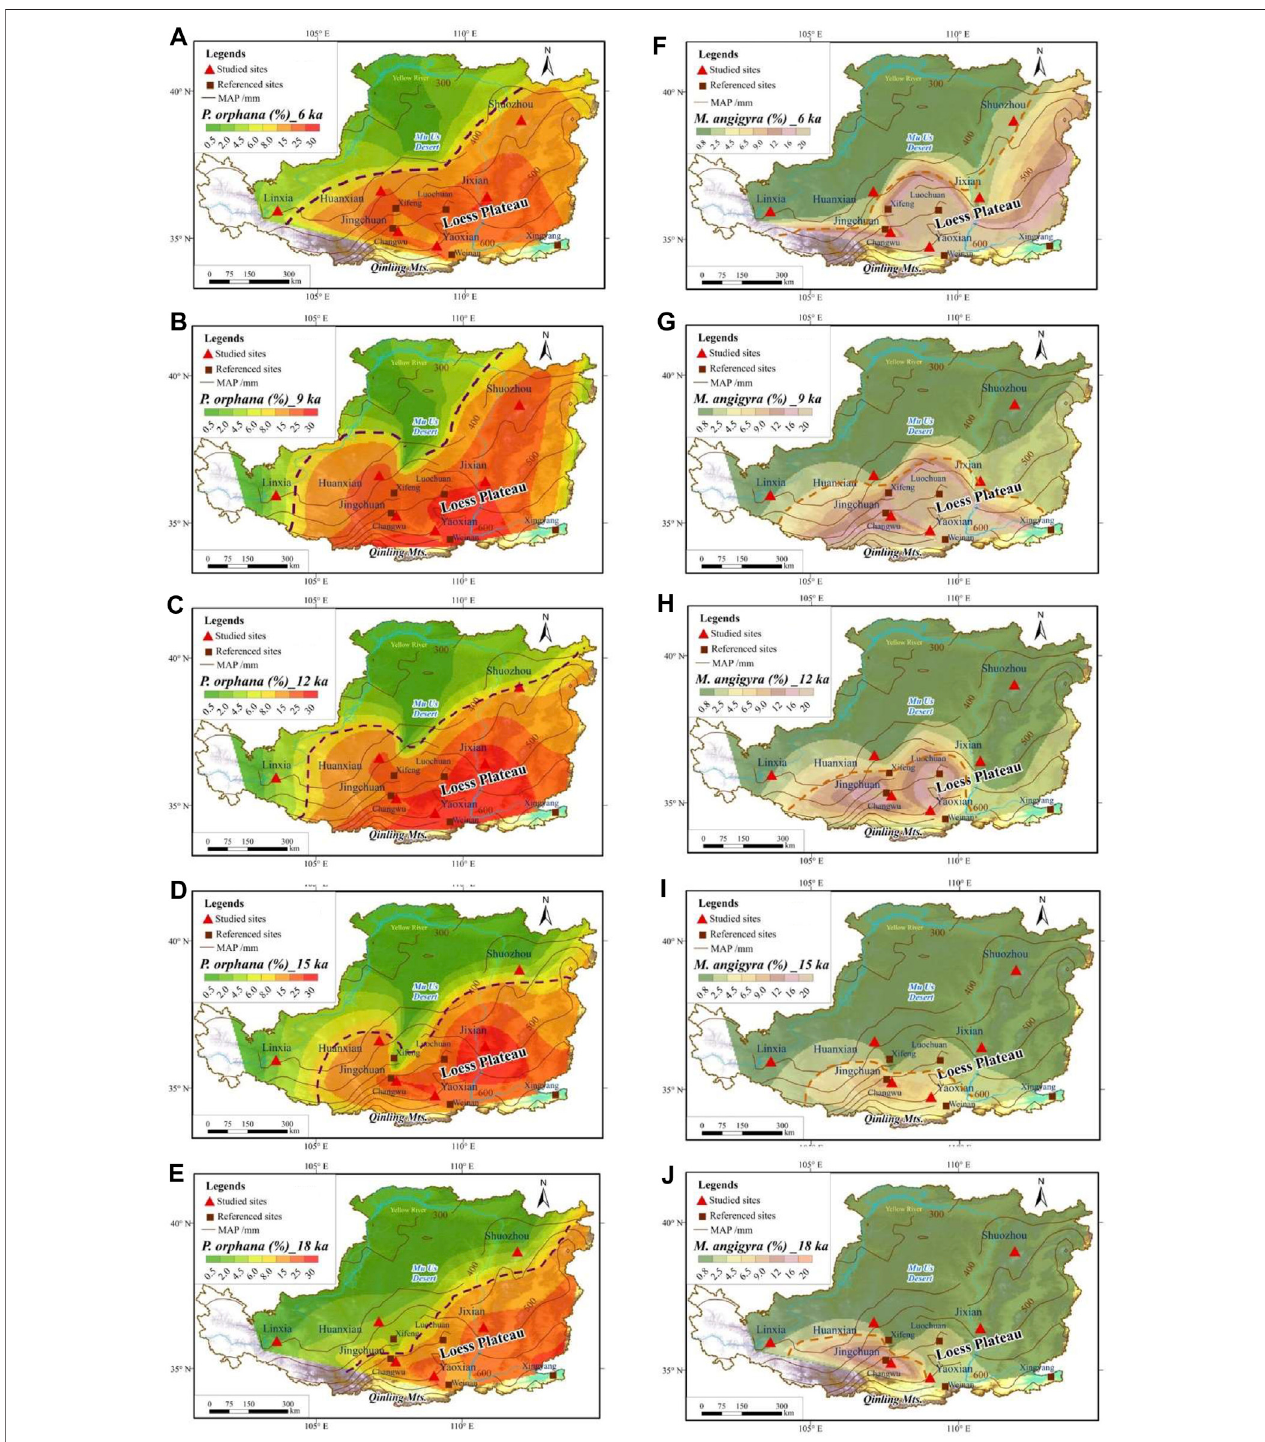
FIGURE4| Contourmapsoftheabundanceof P.orphana and M.angigyra forthetimeslicesof ∼ 6 ka (A,F) , ∼ 9 ka (B,G) , ∼ 12 ka (C,H) , ∼ 15ka (D,I) ,and ∼ 18 ka (E, J) since the last deglaciation. The modern mean annual precipitation distribution over the past 50 years is also shown. Red dotted lines show the reference values of the 4.5 and 2.5% isolines of P. orphana and M. angigyra , respectively.